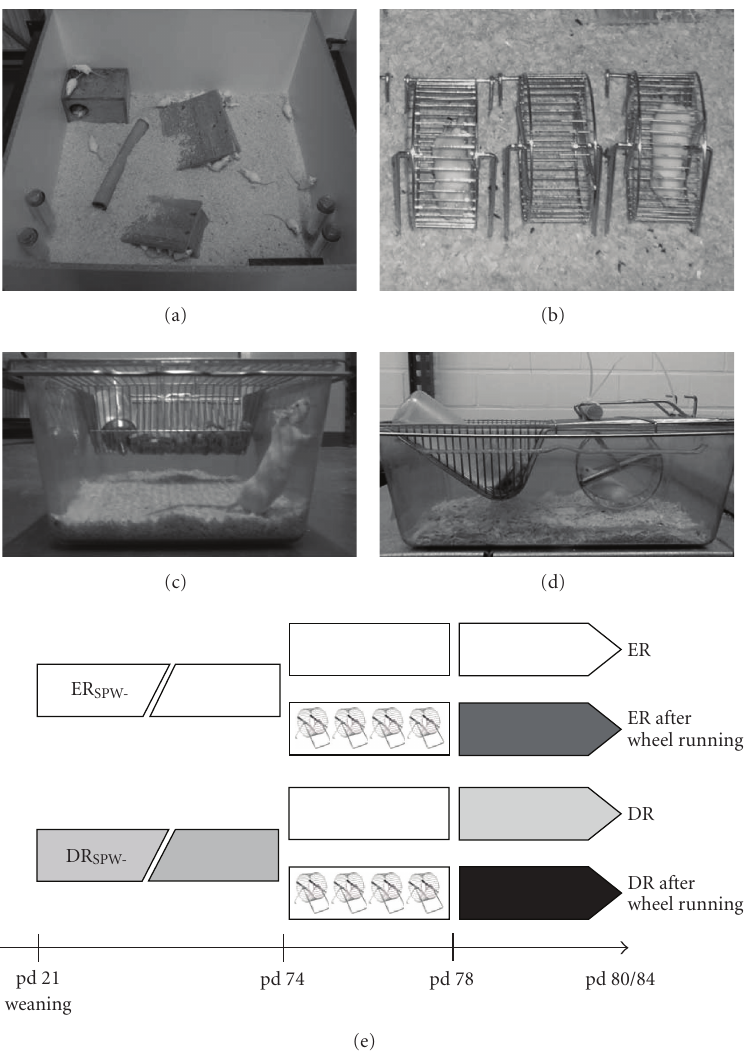
Figure 1: ( a) Mice in socially and physically enriched-rearing condition. (b) Wheel running of group-housed individuals; (c) Mouse in a cage of the socially and physically deprived-rearing condition. (d) Mouse wheel running in its individual cage as in (c). (e) Experimental design with time axis showing animal age in postnatal days (pd); pd 21–74, rearing phase under socially and physically enriched conditions (ERs) or socially and physically deprived conditions (DRs); pd 74–78, 4-day wheel running challenge for the half of each rearing group; synaptic-remodeling rates were assessed between pd 80 and